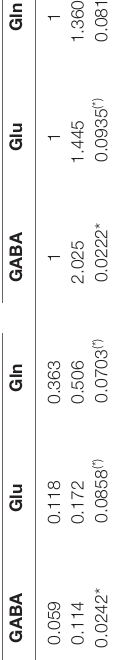
F (3,58) = 0.09379, Dunnett’s multiple comparison’s test, WT: saline vs. 0.75 mg/kg p = 0.8601, saline vs. 1.5 mg/kg p = 0.2785, saline vs. 3 mg/kg: p = 0.0118; KO: saline vs. 0.75 mg/kg p = 0.9861, saline vs. 1.5 mg/kg p = 0.8595, saline vs. 3 mg/kg: p = 0.0205). To further analyze the effects of the three doses of R-Baclofen on short-term habituation between Cntnap2 WT and KO rats, we performed straight-line regressions of the habituation scores depending on the treatment, and compared the slopes and elevations of the two regression lines ( Figure 5C ). The elevations of the regression lines were significantly different in Cntnap2 KO compared with WT rats, resulting from the overall greater habituation scores across treatments in Cntnap2 KO rats ( Figure 5C , Cntnap2 WT: n = 9–11 rats, elevation: c = 0.8004, Cntnap2 KO: n = 11 rats, elevation: c = 1.073, p = 0.0093). The slopes were similar in Cntnap2 WT and KO rats, showing a negative relationship between the R-Baclofen dose and habituation score in both genotypes (i.e., the higher the dose, the lower the habituation score, Figure 5C , Cntnap2 WT: n = 9–11 rats, slope: m = − 0.1273, Cntnap2 KO: n = 11 rats, slope: m = − 0.1514, p = 0.6940). This indicates that the selective activation of GABA B receptors by R-Baclofen had a similar suppressive mode of action on habituation scores in Cntnap2 WT and KO rats. In contrast to short-term habituation, R-Baclofen did not induce a statistically significant reduction in sensitization scores, neither within nor between Cntnap2 WT and KO rats ( Figure 5D , two-way RM-ANOVA, Cntnap2 WT: n = 11 rats, Cntnap2 KO: n = 11 rats, genotype p = 0.0966, F (1,20) = 3.040, treatment p = 0.1430, F (2.628, 52.56) = 1.930, treatment × genotype p = 0.5867, F (3,60) = 0.6490; Linear regression, Cntnap2 WT: Y = − 0.04851 * X + 0.8589, Sy. x = 0.05019, Cntnap2 KO: Y = − 0.08989 * X + 1.014, Sy. x = 0.05991, WT vs. KO: slopes p = 0.3053, elevation p = 0.0548). Taken together, our results suggest that higher doses of R-Baclofen have the potential to improve deficient sensory filtering in Cntnap2 KO rats by enhancing short-term habituation. Sensitization of the ASR, however, appeared insensitive to the influence of R-Baclofen. This indicates that the cellular mechanisms or neural circuits controlling short-term habituation and sensitization are not affected the same way by selective activation of GABA B receptors though systemic administration of R-Baclofen.